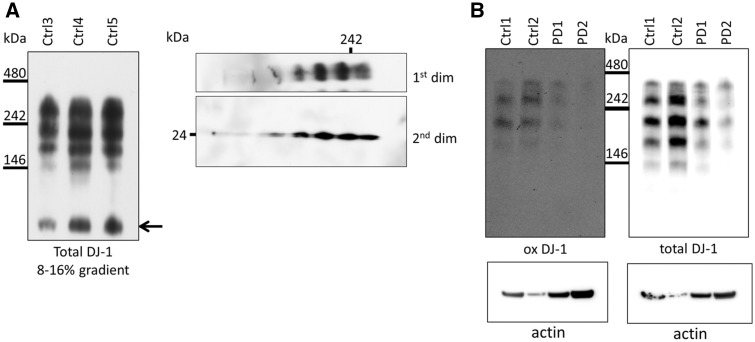
DJ-1 HMW complexes are the predominant species in human brain and show evidence of oxidation. (A) Left: Soluble complexes from putamen of three healthy individuals were examined using 8-16% gradient BisTris gels and subsequent western blot analysis for total DJ-1. No monomeric DJ-1 was detectable in putamen in native lysates. However, based on its molecular weight a band perhaps representing DJ-1 homodimer was detected (indicated by arrow). Representative western blot is shown (n = 3). Right: The soluble complexes from human putamen were analysed by two dimensional BN/SDS PAGE and western blotting for total DJ-1, which was detectable in all four complexes, illustrating that the DJ-1 signal is specific. Representative western blot is shown (n = 2). (B) Soluble complexes from cortex of two healthy individuals and two PD patients were separated on 7.5% fixed percentage BisTris gels and subsequently probed for oxidized DJ-1 (ox DJ-1) and total DJ-1. Representative western blot is shown (n = 2). Protein loading of brain samples used for BN-PAGE was assessed by measuring an aliquot of each sample for β-actin by SDS-PAGE (panel underneath BN PAGE).